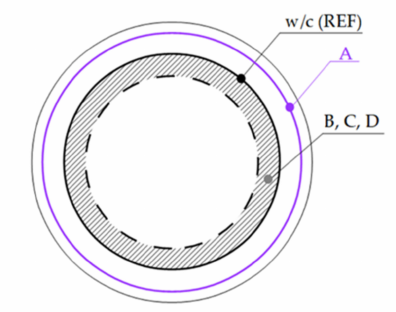
Figure 19. Predicted consistencies (flow diameters on Haegerman’s table) of fresh mixtures depend- ing on the type of mineral